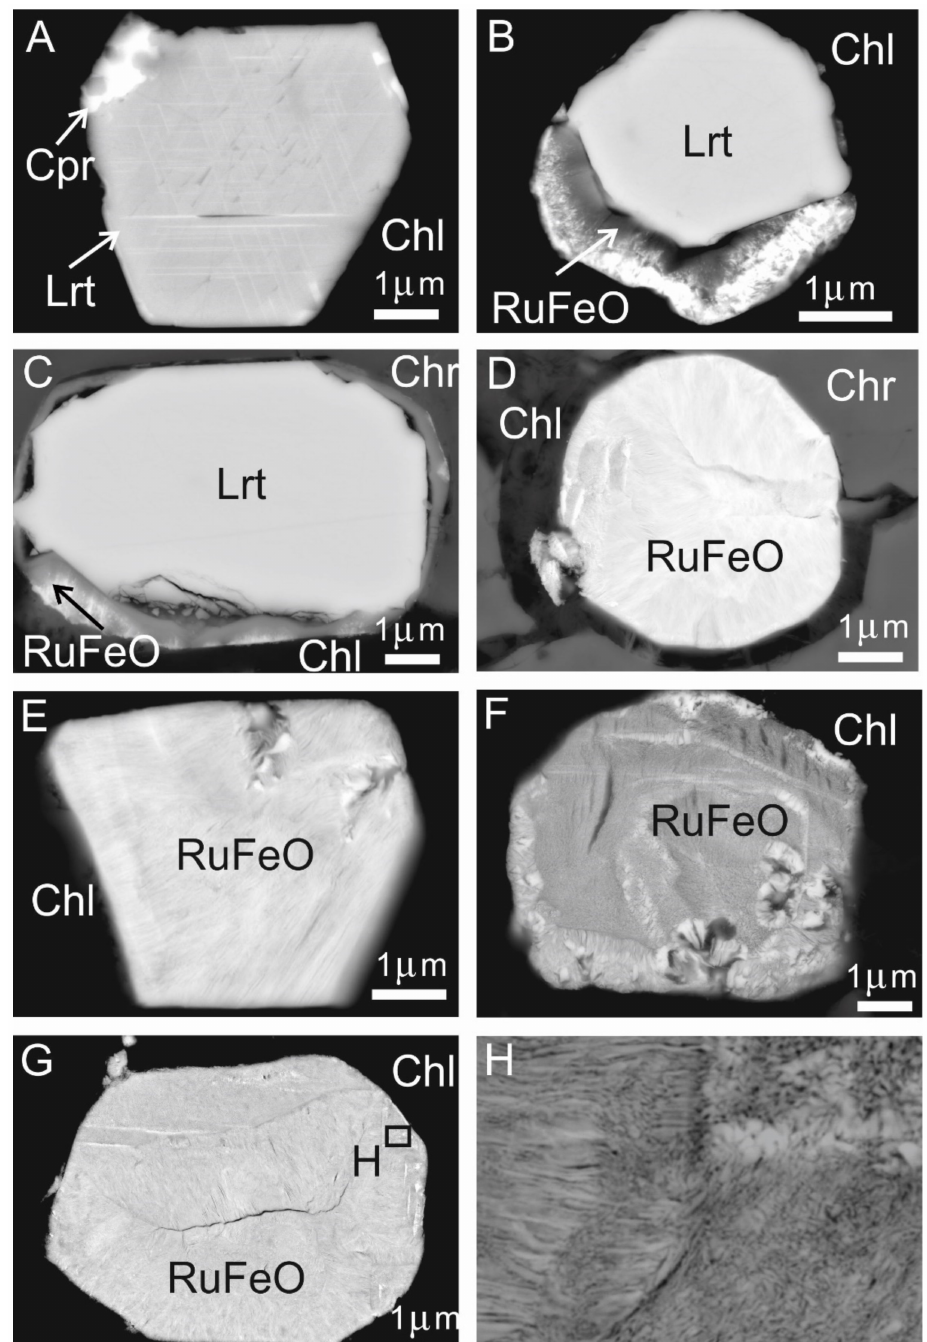
Figure 12. Field emission (FE-SEM) images of PGM associated with the chromitites of Sebuku Island showing euhedral laurite in contact with cuproiridsite and lamellae of iridium ( A ), unaltered core of laurite rimmed by Ru-Os-Ir-Fe-O phase ( B – D ), polygonal grains of Ru-Os-Ir-Fe-O occurring in contact with chlorite ( E – G ), enlargement of the grain of Figure ( G , H ). Abbreviations: